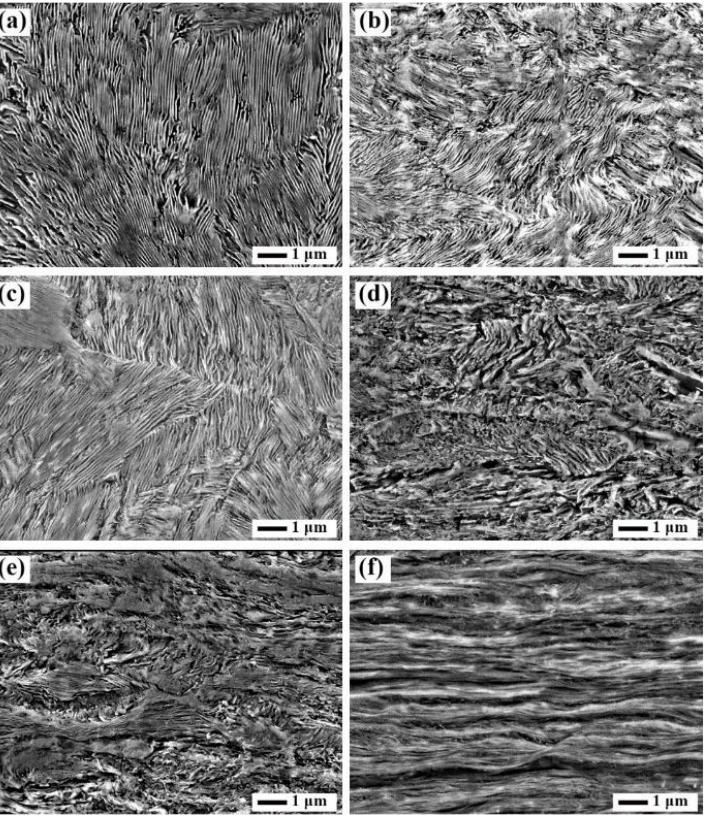
Figure 1. SEM micrographs showing the pearlite structure of the SK85 steel before cold rolling ( a ) and at a rolling reduction of ( b ) 10%; ( c ) 30%; ( d ) 50%; ( e ) 70%; and ( f ) 90%.